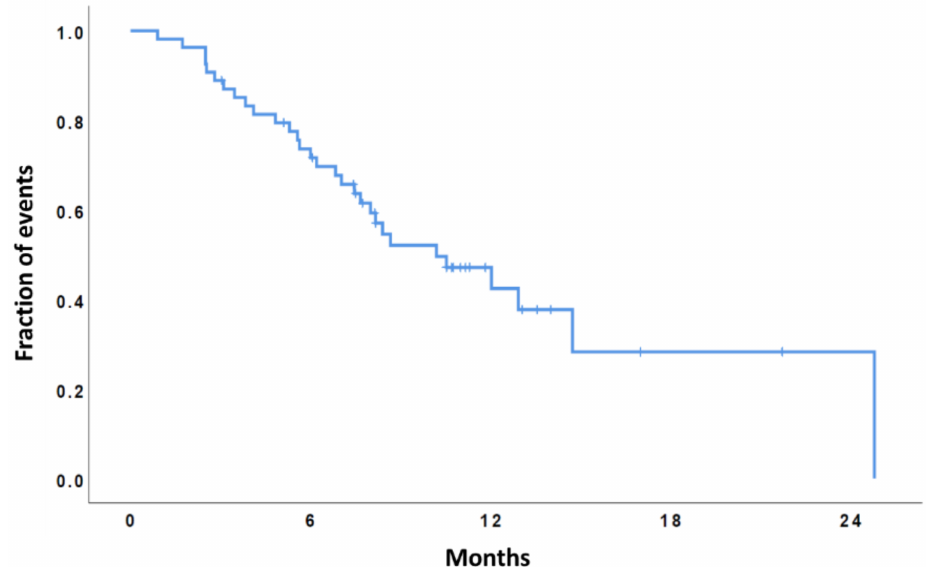
Figure 2. Kaplan-Meier curve of overall survival (the median OS was 10.2 months, 95% CI 6.4–13.9).